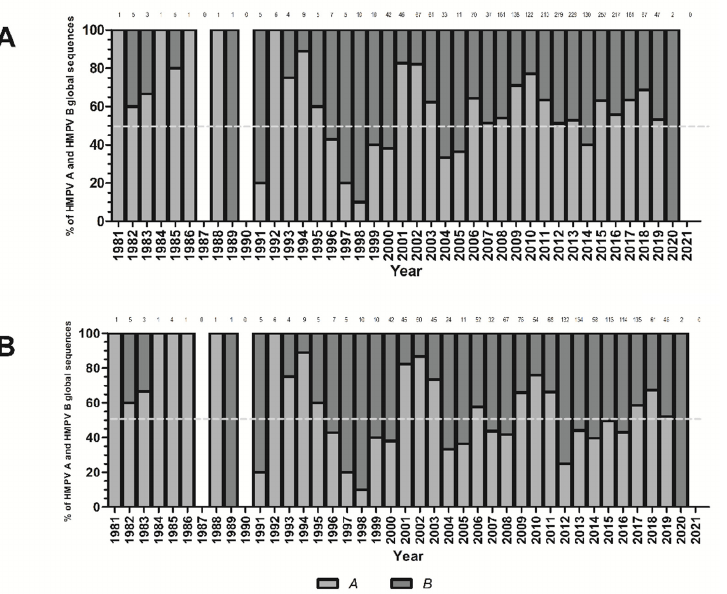
Figure 1. Proportion of human metapneumovirus (HMPV) A and HMPV B sequences available globally for each year between 1981 and 2021, including all 2538 HMPV G gene sequences identified